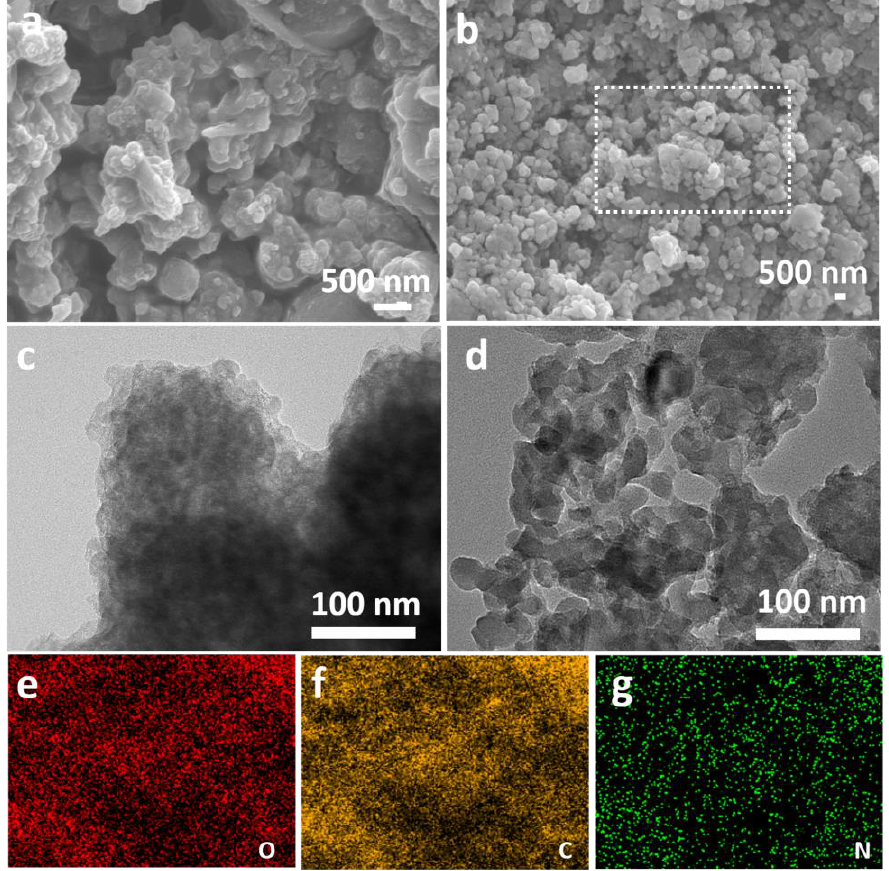
Figure 2. ( a , b ) SEM images of CLN and CMLN; ( c , d ) TEM images of CLN and CMLN; ( e – g ) elemental mapping of C, N and O for CMLN.